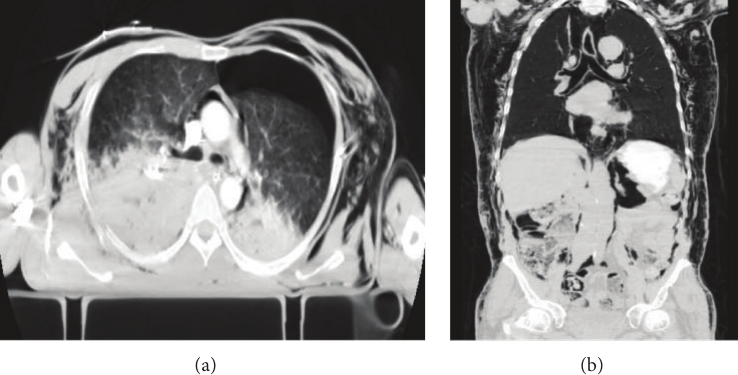
Figure 18: Subcutaneous emphysema. Axial MDCT (a) and coronal reconstruction (b) in lung window. An extensive subcutaneous